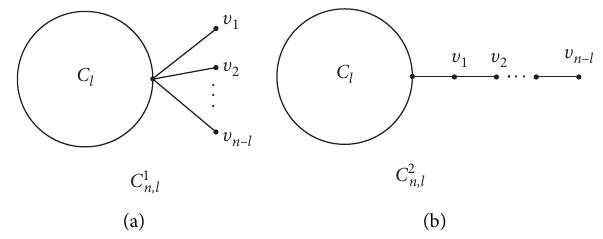
Figure 4: The graphs C 1